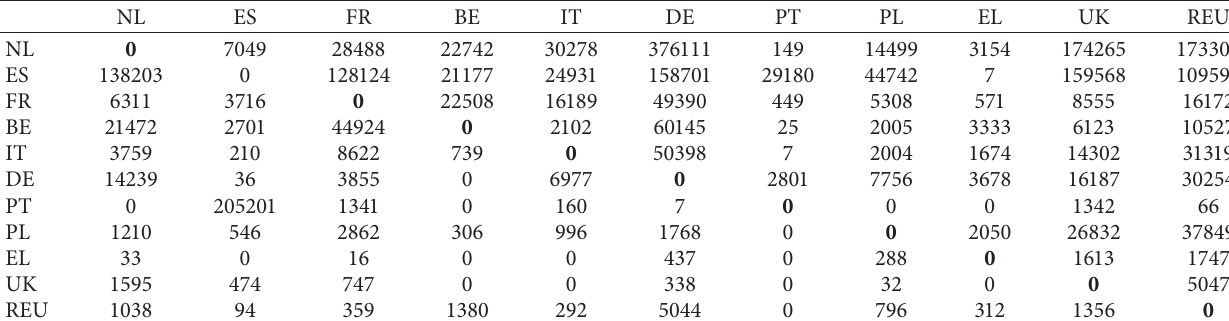
Table 4: Matrix of trade transactions 2007.